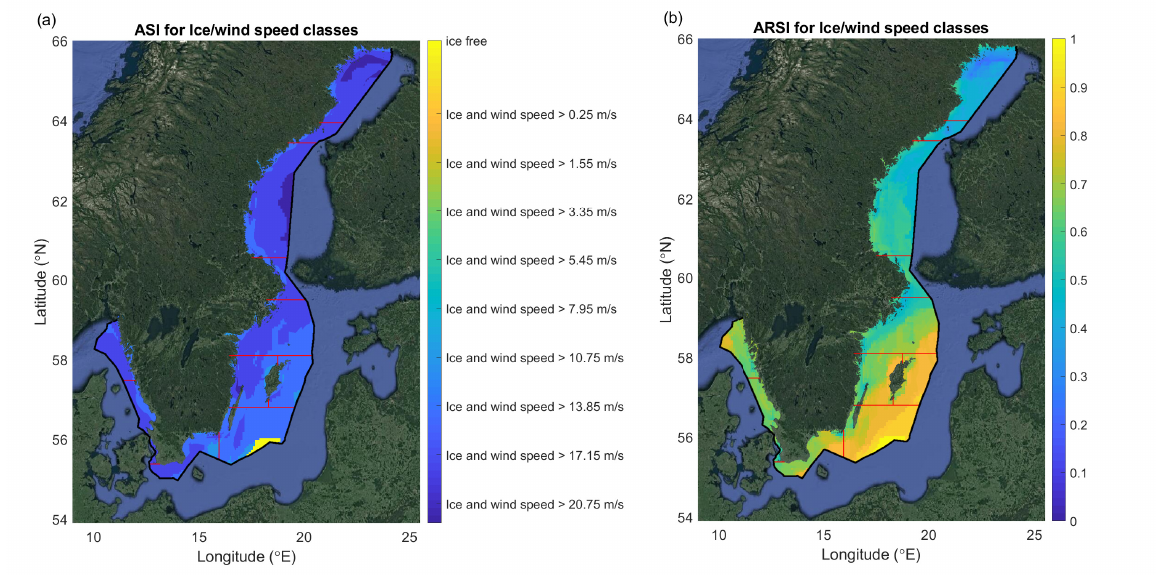
Figure 8. The ASI for the ice/wind speed aspect based on considering any presence of ice and wind speed categories (in ( a )) and considering the percentile limits (in Figure 4c) to formulate the ARSI in ( b ). A value of one indicates ice-free or non-critical wind speed during ice conditions for all categories considered, and low values imply the presence of potentially critical wind speed during ice conditions for many of the categories considered. Sub-basin borders following Figure 1 are marked with red